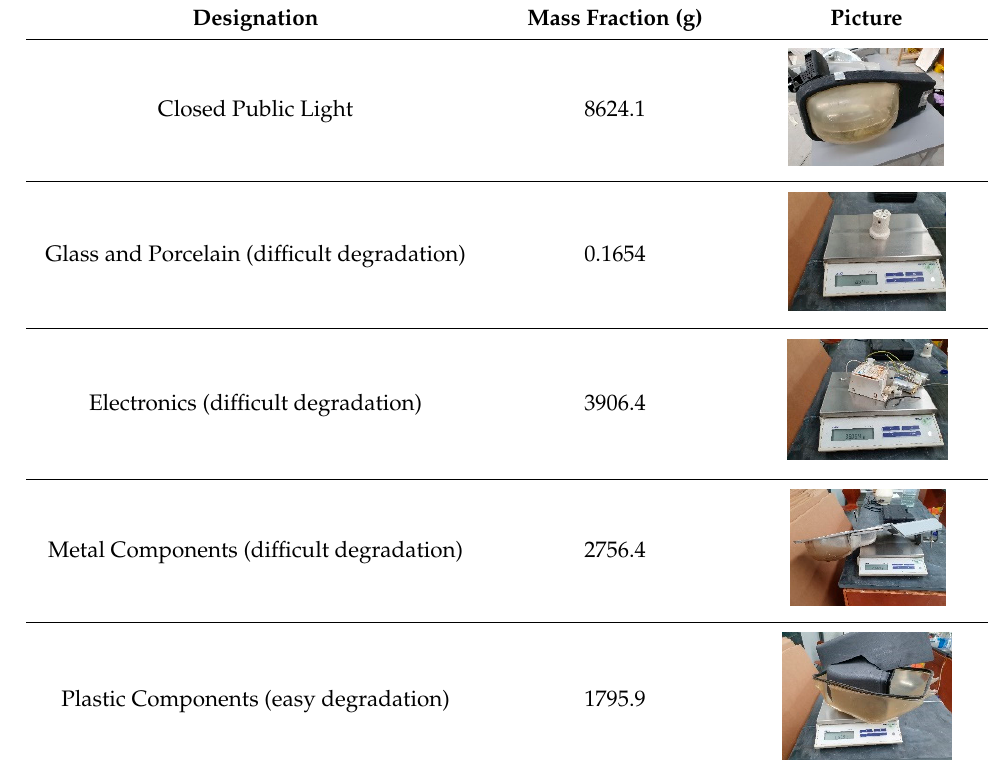
Table 7. Measurement by the weight of the Syntra luminary decompressed.